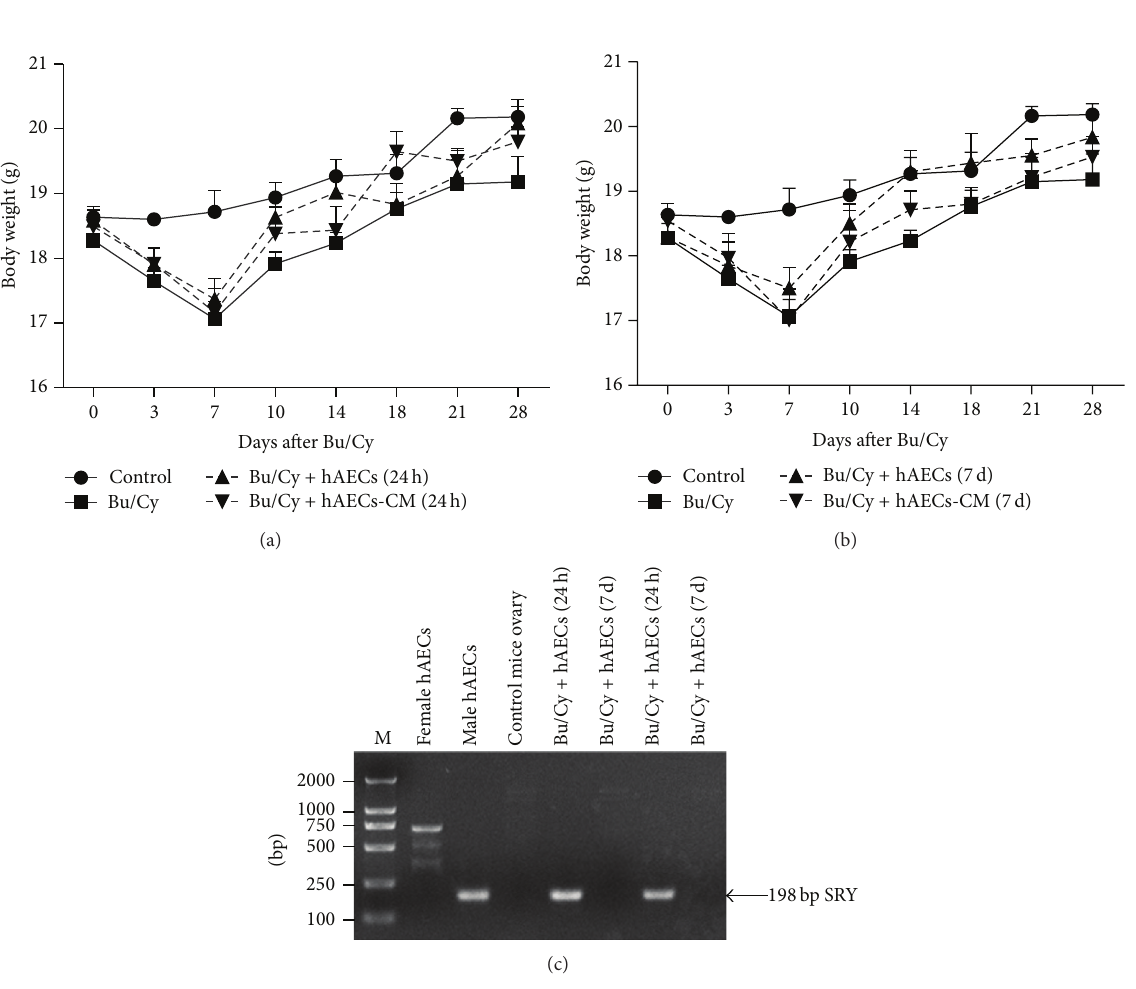
Figure 2: The effect of human hAECs and hAECs-CM administration on mice body weight and the detection of transplanted hAECs. (a) Weight of mice treated with hAECs and hAECs-CM 24 hours after chemotherapy. The weight of Bu/Cy-treated administrated mice decreased significantly 7 days after chemotherapy when compared with mice in the control group ( 𝑃 < 0.01 ). Mice of hAECs- and hAECs-CM-treated groups weighed more compared with Bu/Cy mice treated with Bu/Cy administrated at any time point, although the differences were not significant. (b) The weight of mice that received Bu/Cy treatment and then an IP injection of hAECs or hAECs-CM 7 days later. (c) A representative gel electrophoresis of detection of the SRY gene in female mice ovaries treated with male hAECs by a simultaneous nested PCR analysis. The nested amplified product of the SRY sequence on the Y chromosome is 198bp in